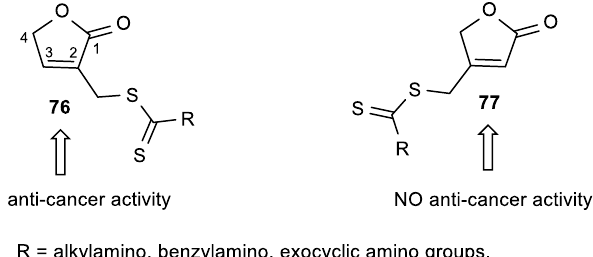
Figure 29. The butenolides 76 and 77 with a dithiocarbamate side chain. Table 30. The antitumor activities of butenolides 76 with a dithiocarbamate side chain. Comp.